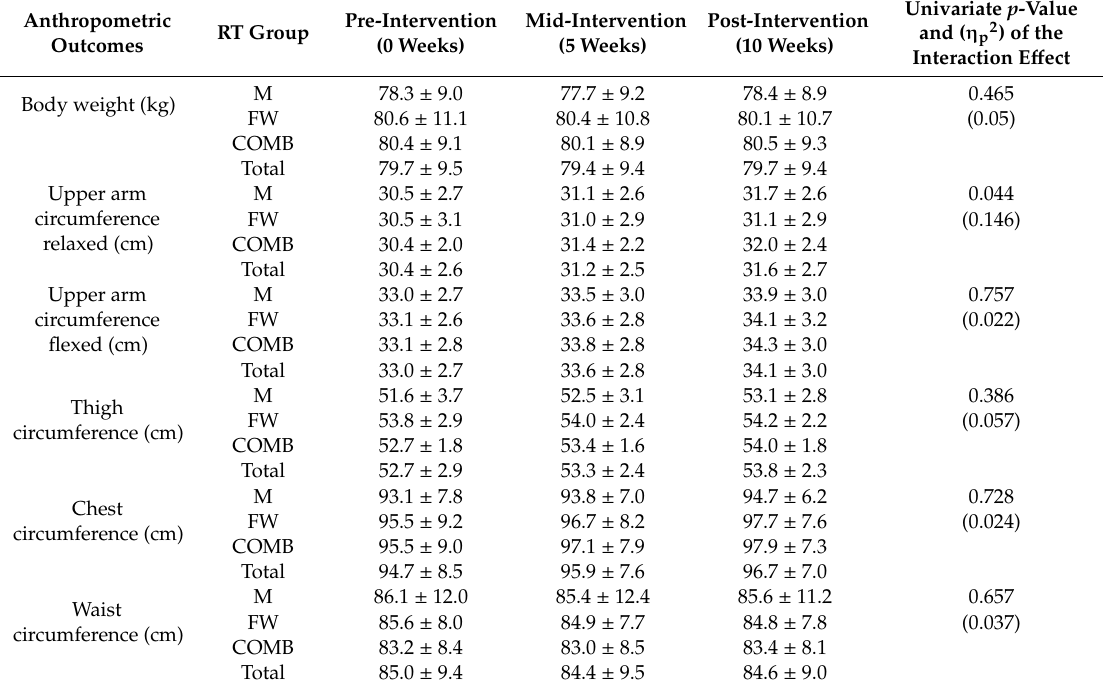
Table 3. Anthropometric measurements (mean ± SD) according to RT group and